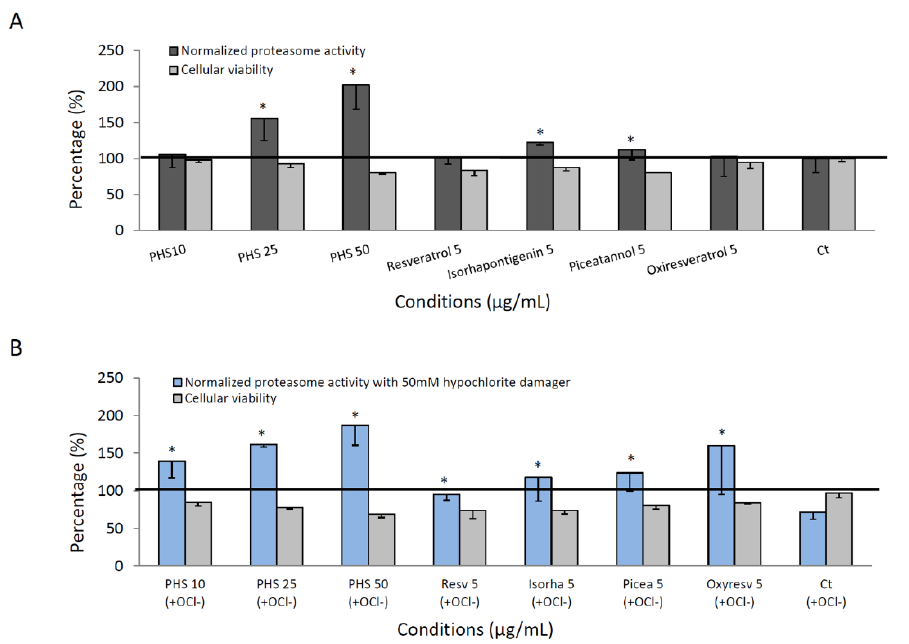
Figure 5. Activation and the protective effect on the proteasome of five pure stilbenoids. ( A ) Deter- mination of the effects of piceatannol, oxyresveratrol, resveratrol, isorhapontigenin, and 3,3′,4,5,5′ - pentahydroxy-trans-stilbene (PHS) on the proteolytic activity of the proteasome in human NHDF- aged cells. ( B ) Ability to purify PHS or commercial compounds to reverse the proteasome inhibition by the OCl − oxidant. The data are presented as mean (SD) values for each experimental condition (n = 3), and a nonparametric Mann – Whitney test analysis was used to compare the statistical difference between pure compounds: the stars show a significant difference between control (Ct) and other conditions. * Indicates statistically significant differences as compared to controls ( p < 0.05).